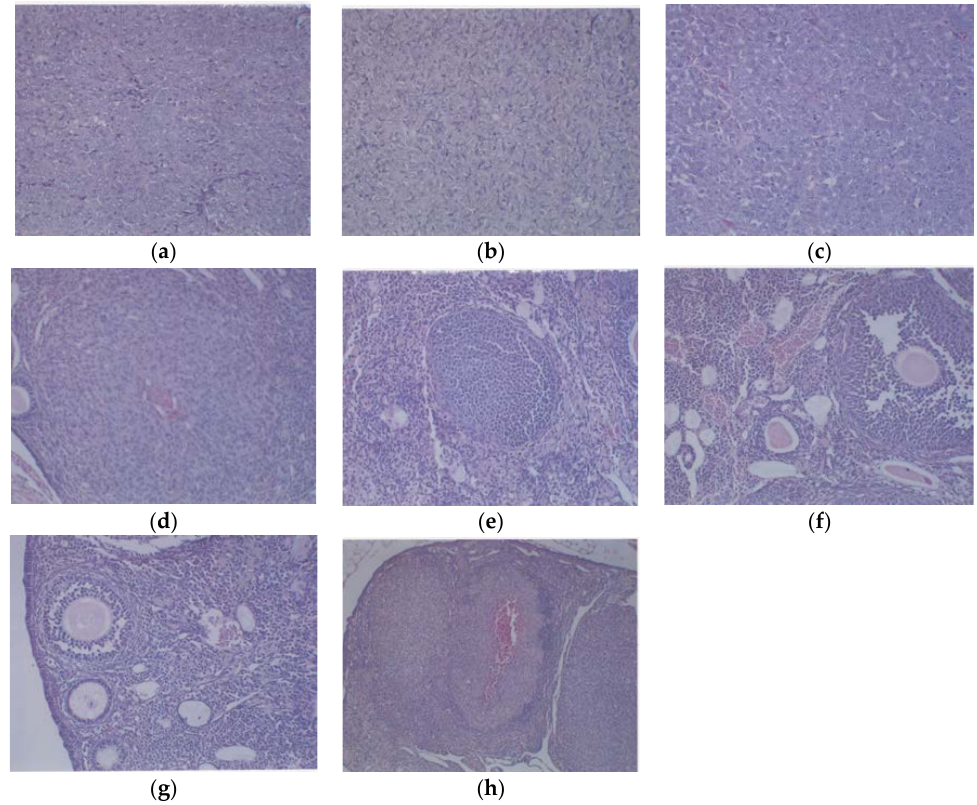
Figure 5. Histology of representative ovaries in groups: magnification 200 × except ( h ) which is 100 ×